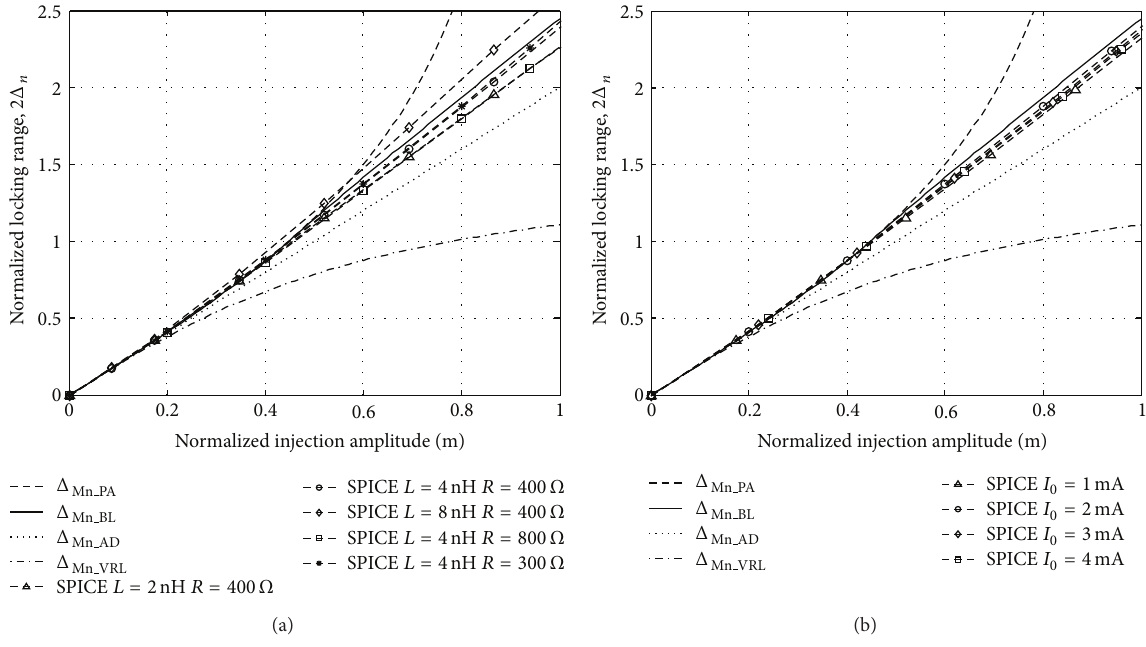
Figure 3: Normalized locking ranges for an ILFD with saturation-like nonlinearity. Parameters of the SPICE simulations of the circuit in Figure 1 are the following: 𝐿 = 4 nH, and 𝑅 = 400 , 𝜔 0 = 1.8 GHz, 𝐼 0 = 2 mA, 𝑘 = 2.6/𝑉 .